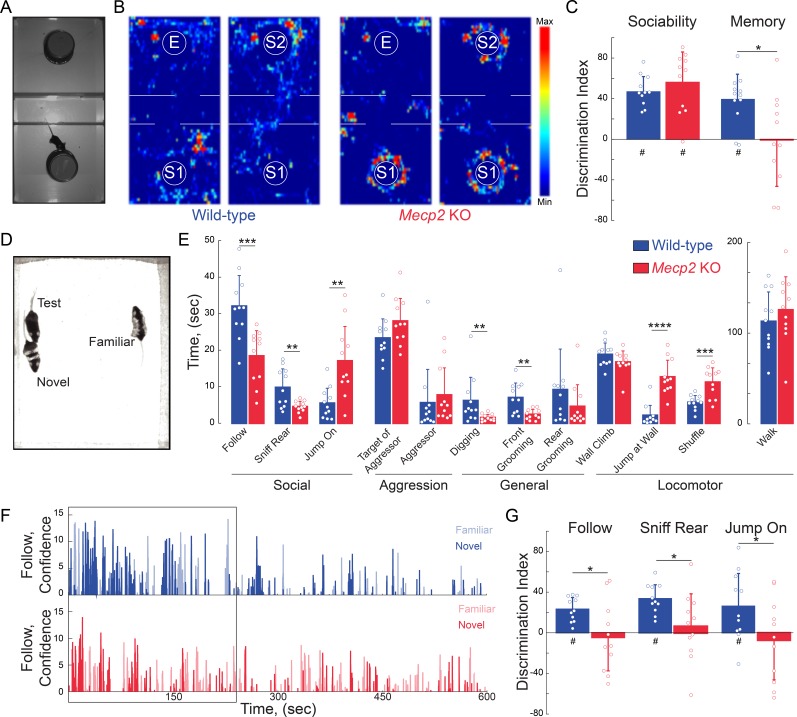
Mecp2 KO mice have impaired social memory and atypical social interactions.(A) Schematic of three-chamber social test. (B) Representative heat maps of WT and Mecp2 KO mice during the three-chamber social test. (C) Discrimination indices of sociability and memory tests. (n = 12 WT mice; n = 11 Mecp2 KO mice; WT vs. Mecp2 KO sociability, p=0.3523; WT vs. Mecp2 KO, memory p=0.0140; Two-sample Student’s t-test; WT sociability DI vs. chance, p<0.0001; Mecp2 KO sociability DI vs. chance, p<0.0001; WT memory DI vs. chance, p=0.0002; Mecp2 KO memory vs. chance, p=0.9436; One-sample Student’s t-test). (D) Image of unrestricted social memory paradigm. (E) Time spent performing different behaviors using automated scoring of unrestricted social encounters (n = 11 WT mice; n = 11 Mecp2 KO mice; Follow, p=0.0008; Rear Sniff, p=0.0055; Jump On, p=0.0020; Target of Aggressor, p=0.0857; Aggressor, p=0.1513; Digging, p=0.0052; Grooming Front, p=0.0025; Grooming Rear, p=0.1875; Wall Climb, p=0.1713; Wall Jump, p<0.0001; Shuffle, p=0.0007; Walk, p=0.4135; Student’s t-test or Mann-Whitney test dependent on normalcy). (F) Computer confidence scores in following behavior over the course of representative videos separated by target: novel mouse in bold and familiar opaque, first 4 min boxed. (G) Time the test mouse spent following, sniffing rear, or ‘jumping on’ either the novel or familiar mouse during the first 4 min of the video (n = 11 WT; n = 11 KO mice; WT Follow DI vs. chance, p<0.0001; WT Rear Sniff, p<0.0001; WT Jump On, p=0.0279; Mecp2 KO Follow p=0.6683, Mecp2 KO Rear Sniff, p=0.5656; Mecp2 KO Jump On, p=0.5665; Two-sample Student’s t-test;WT vs. Mecp2 KO Follow, p=0.0200; WT vs. Mecp2 KO Sniff, p=0.0229; WT vs. Mecp2 KO Jump On, p=0.0493; One-sample Student’s t-test). Mean ± SD; *p<0.05, **p<0.01. For memory tasks (C and G), * indicate comparisons between genotypes while # indicates differences of the discrimination indices from chance value (0). Figure 2—source data 1. See also Figure 2—figure supplements 1–2.10.7554/eLife.44182.010Figure 2—source data 1.Mecp2KO mice have impaired social memory and atypical social interactions.